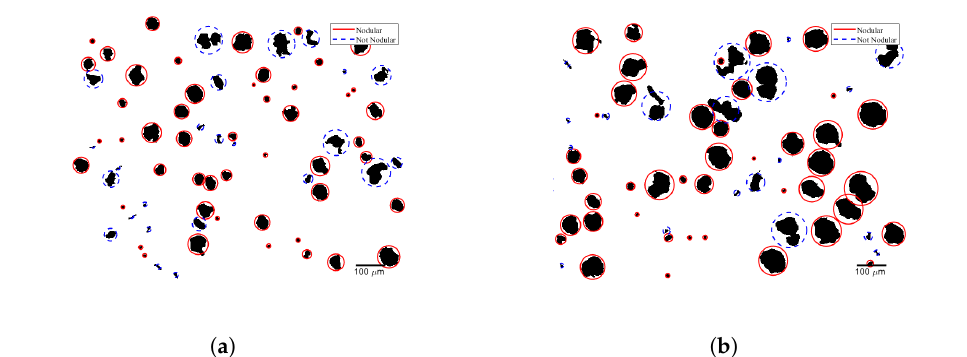
Figure 18. Computational image identification on GGG40. ( a ) GGG40-1. ( b ) GGG40-2.